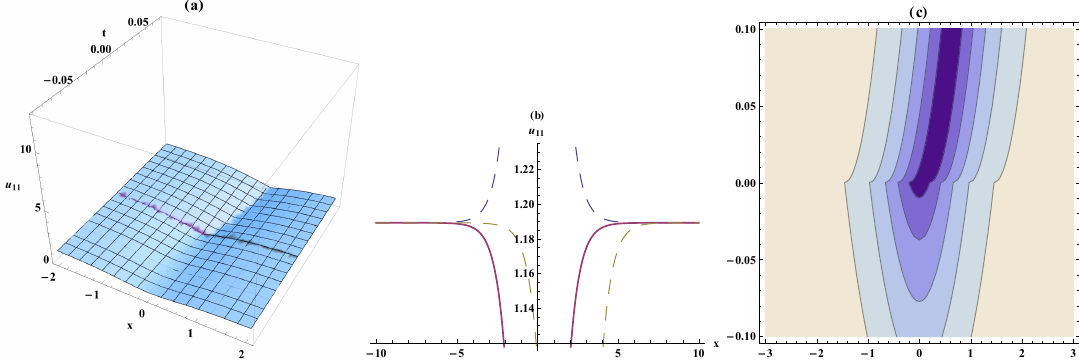
Figure 9. Solitary wave, the bistable wave amplitude, and contour plots for Equation (69). On the respective interval { x , − 2.05,2.05 } , { t , − 0.08,0.08 } , { x , − 10,10 } , { t , − 1,1 } , { x , − 3,3 } , { t , − 0.1,0.1 } .